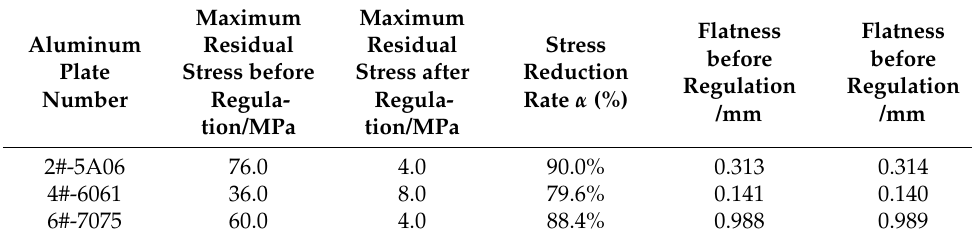
Table 4. Comparison of residual stress and deformation of billet before and after ultrasonic